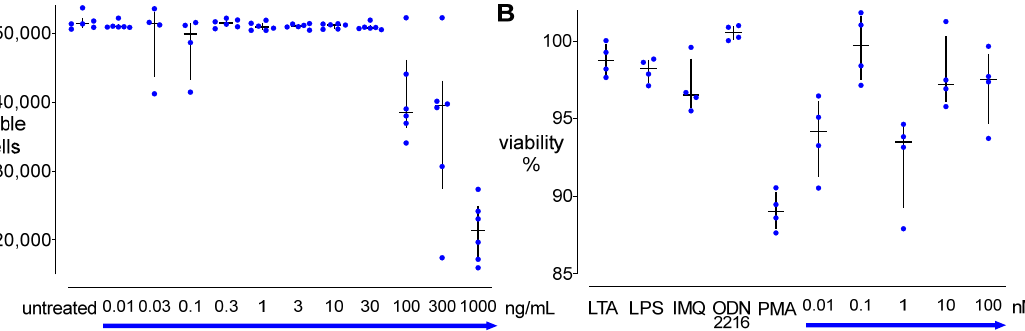
Figure 4. Cell viability of THP-1 cells exposed to different stimuli. ( A ) Viable cells in the samples treated with or without PMA (0.01–1000 ng/mL) for 24 h, n = 6. ( B ) Cell viability was measured in THP-1 cells following 24 h of incubation with or without different stimuli (LTA 10 µ g/mL, LPS 100 ng/mL, IMQ 10 µ g/mL, ODN 2216 1 µ M, and nociceptin 0.01–100 nM), n = 4. Flow cytometry data are presented as percentage of viable cells related to the untreated group (control). Dots, median, and